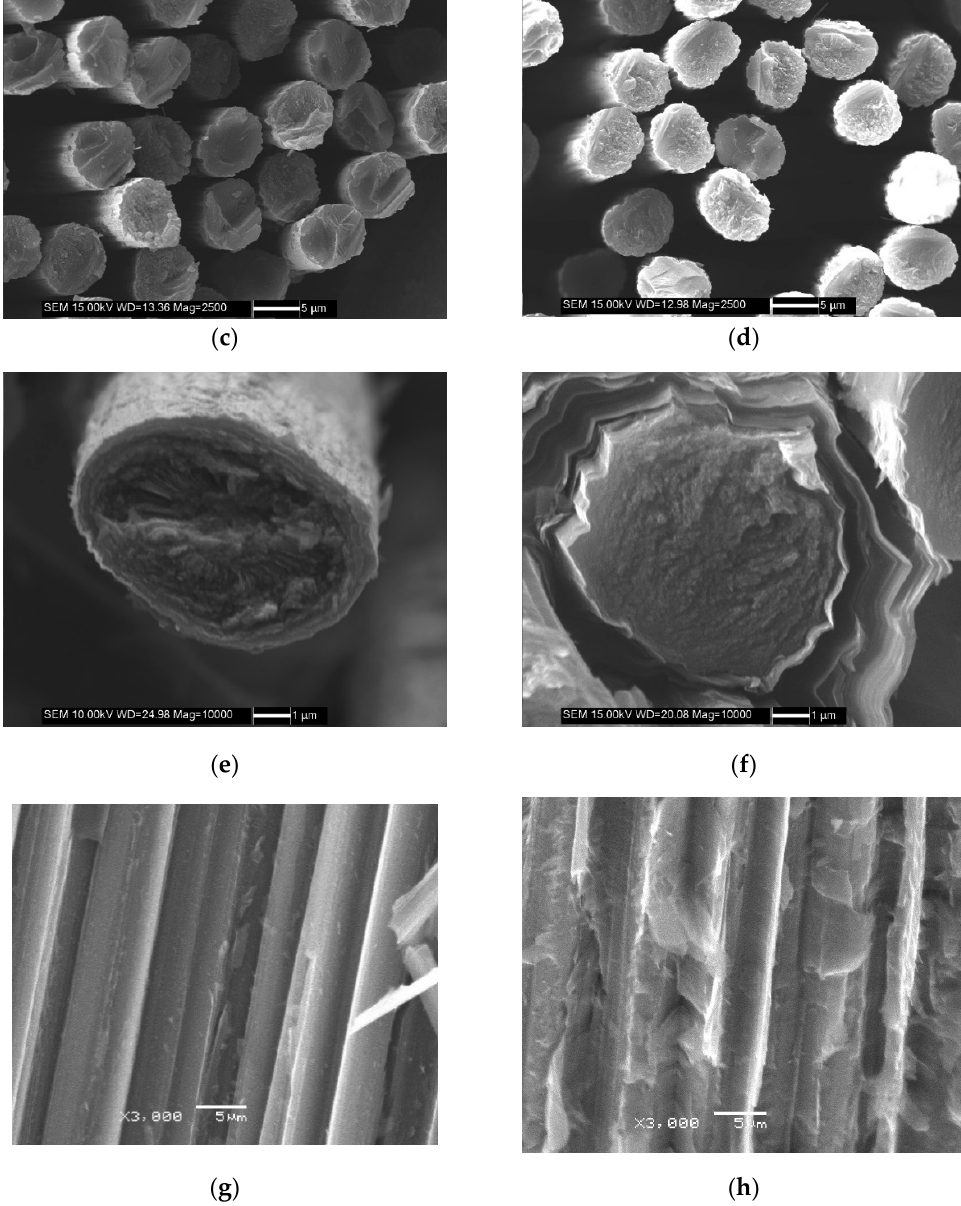
Figure 5. Surface microstructure of the reinforcing phase of axially braided C / C composites. ( a ) Axial micrograph of axially braided C / C composites by SEM; ( b ) Radial micrograph of axially braided C / C composites by SEM; ( c ) Micrograph of the fiber rod end surface by SEM; ( d ) Micrograph of the fiber bundle end surface by SEM; ( e ) Fiber morphology in the reinforcement phase by SEM; ( f ) Interface morphology between fibers and matrix by SEM; ( g ) Cross-section morphology of fiber rod by SEM; and ( h ) Cross-section morphology of fiber bundle by SEM.